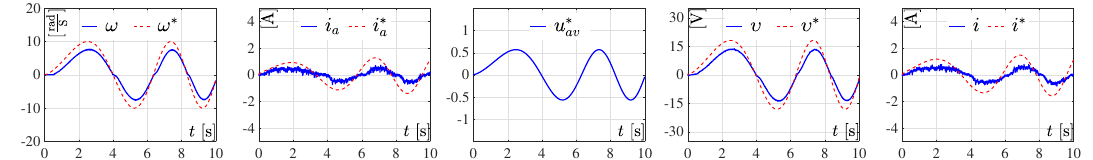
Figure 14. Experimental results for a sinusoidal trajectory with time-varying frequency. The results associated with the measured variables are denoted as ω , i a , υ , i , whereas the results related to the reference variables are labeled as ω ∗ , i ∗ a , u ∗ av , υ ∗ , i ∗